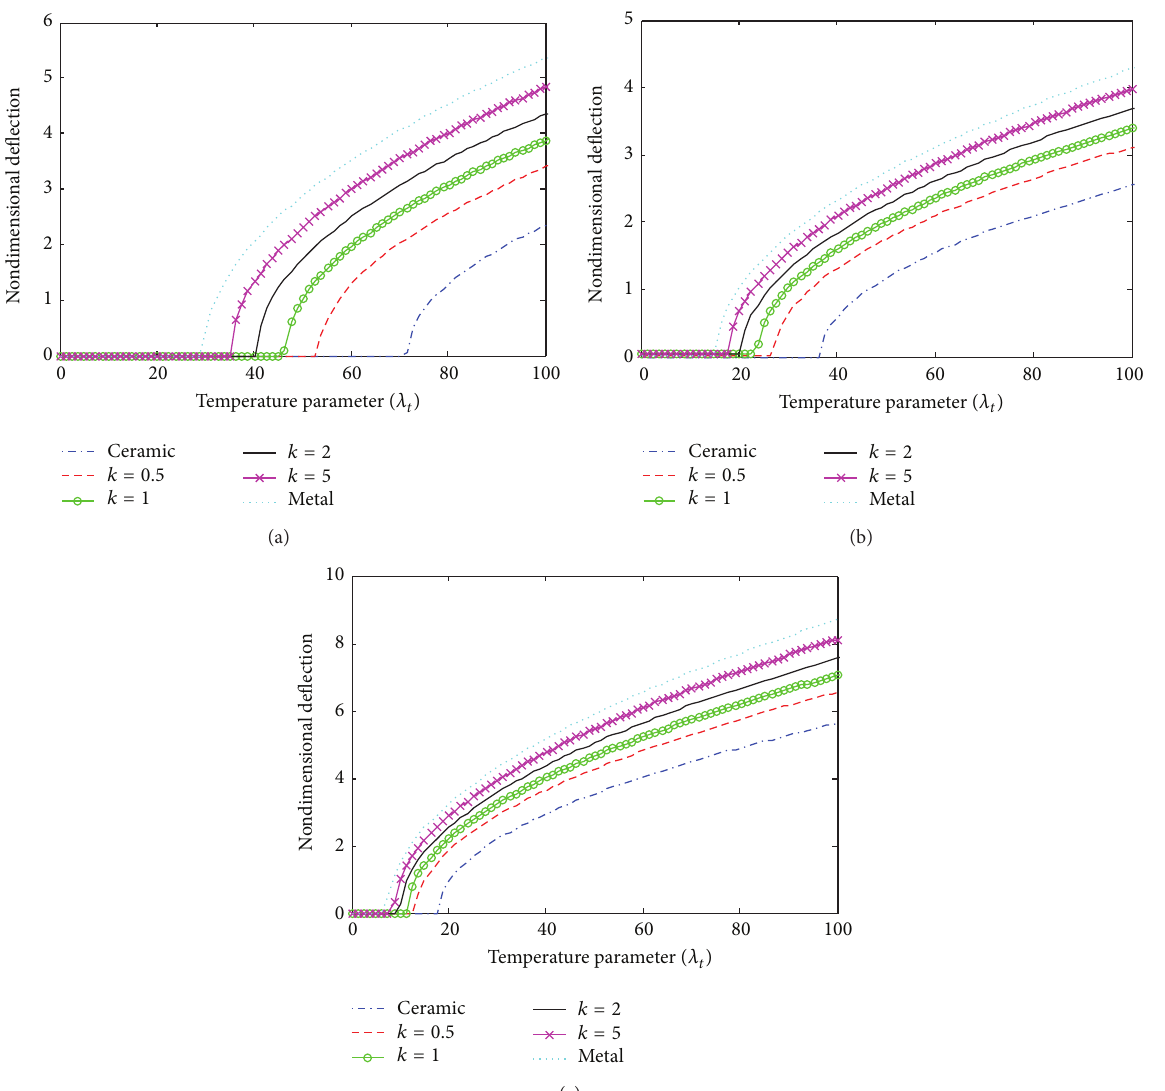
Figure 2: Variation of the nondimensional deflection ( ̂𝑥 = 0.25 ) of (a) clamped-clamped, (b) clamped-simply supported, and (c) simply supported-simply supported FG beam with the temperature parameter for different values of 𝑘 ( 𝑙/ℎ = 1 , 𝐿/ℎ = 40 , first buckling